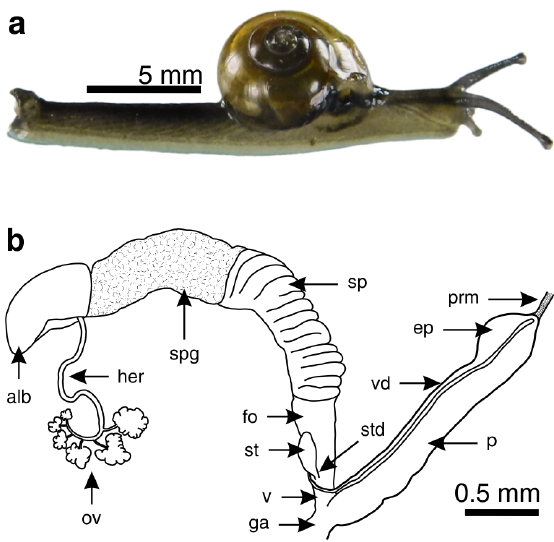
Figure 5 - External morphology and reproductive anatomy of Ovachlamys fulgens . a, living animal; b, schematic drawing of genitalia. Abbreviations: alb, albumen gland; ep, epiphallus; fo, free oviduct; ga, genital atrium; her, hermaphroditic duct; ov, ovotestis; p, penis; prm, penial retractor muscle; sp, spermoviduct; spg, glandular portion of spermoviduct; st, spermatheca; std, spermathecal duct; v, vagina; vd, vas deferens.